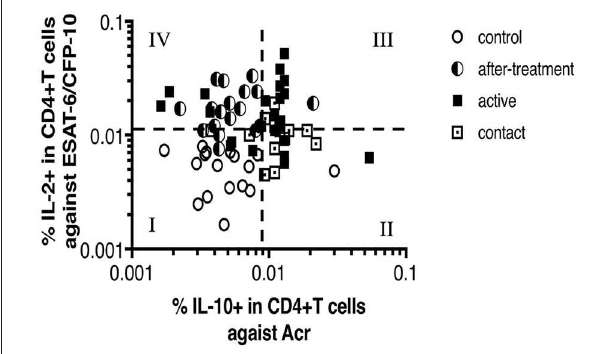
FIGURE 6 | Scatter plot between IL-2 response against ESAT-6/CFP-10 and IL-10 response against Acr in M. tuberculosis -infected cases and control cases ( n = 100, Two points are outside axis limits). This scatter plot was divided into four quadrates, and each quadrate was numbered from I to IV. Most of controls are in No. I quadrate. Contacts and actives are in No. II and No. III quadrates, in particular, actives are noticeable in No. III quadrate. After-treatments are noticeable in No. IV